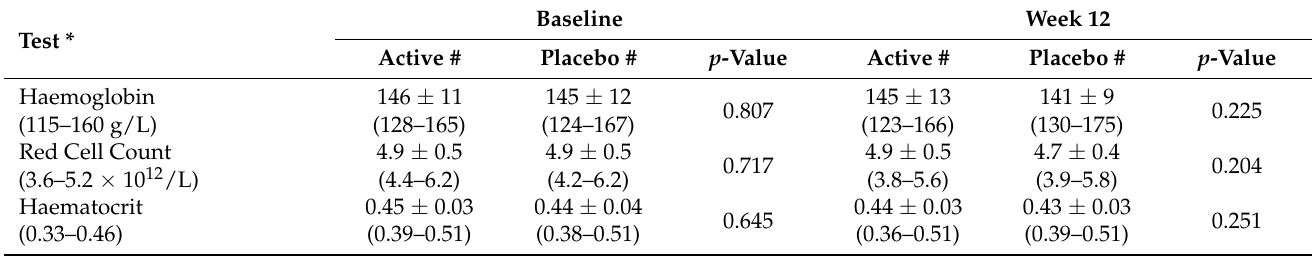
Table 4. Safety profile and metabolic panel for Active treatment and Placebo at baseline and week